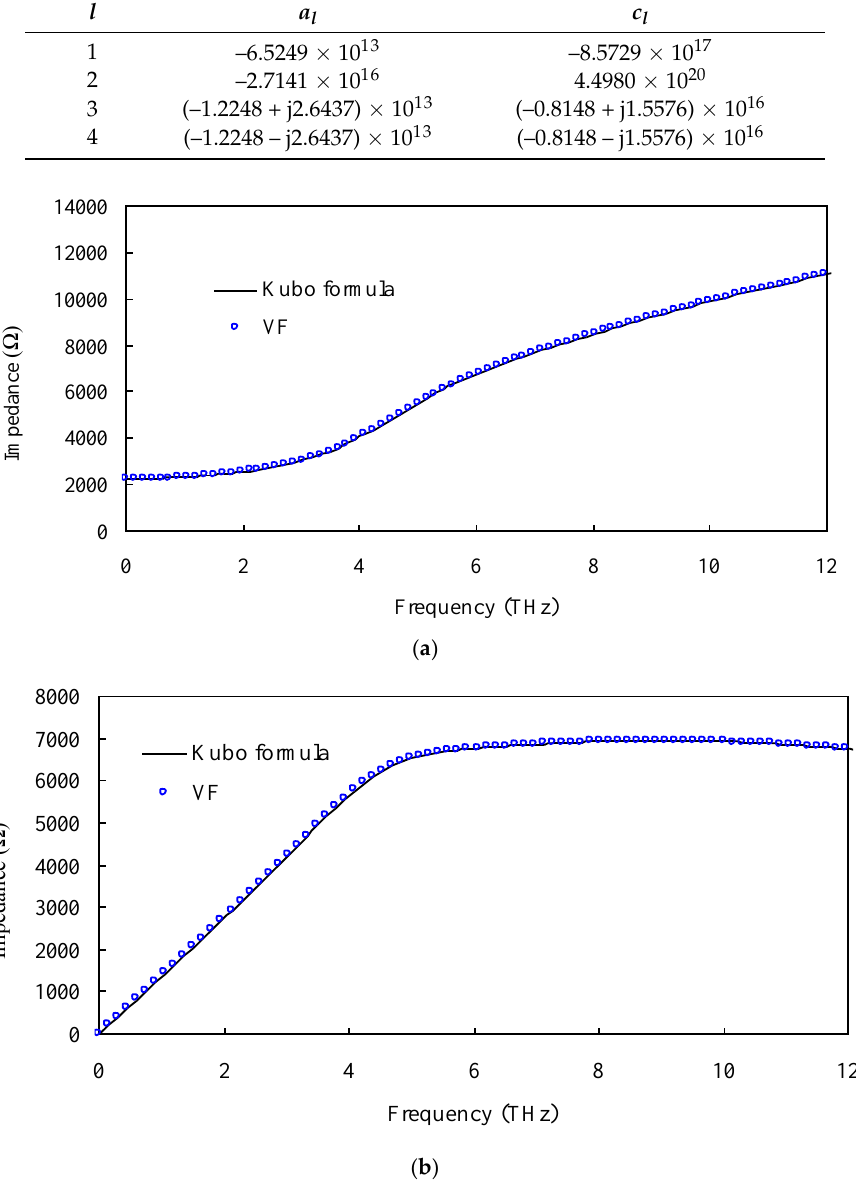
Table 2. The poles a l and residues c l when p = 4.